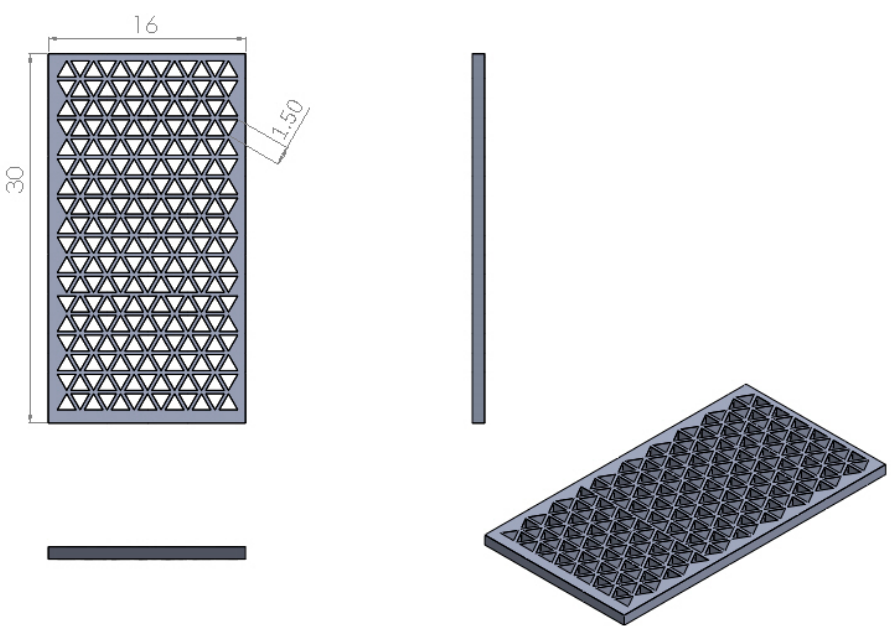
Figure 2. The design of resolution test specimens.